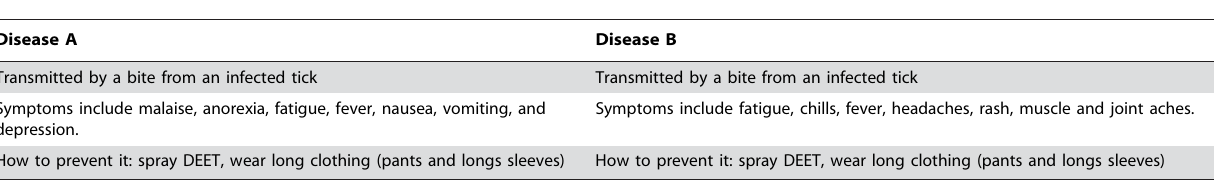
Table 2. Sample Infectious Disease and Alternate Media Pair*.